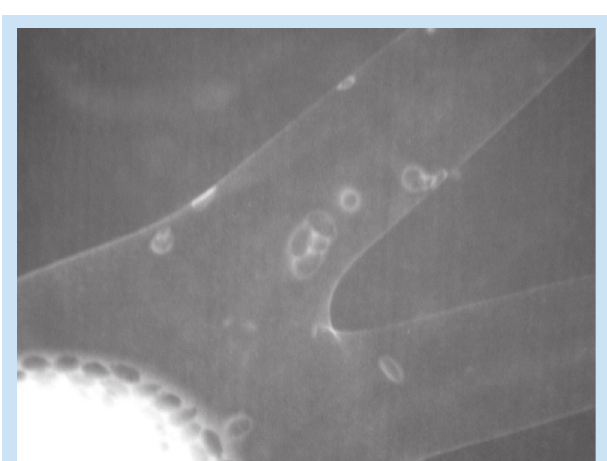
Fig. 1c. Multiple linseed shadows during simulation in latex glove.